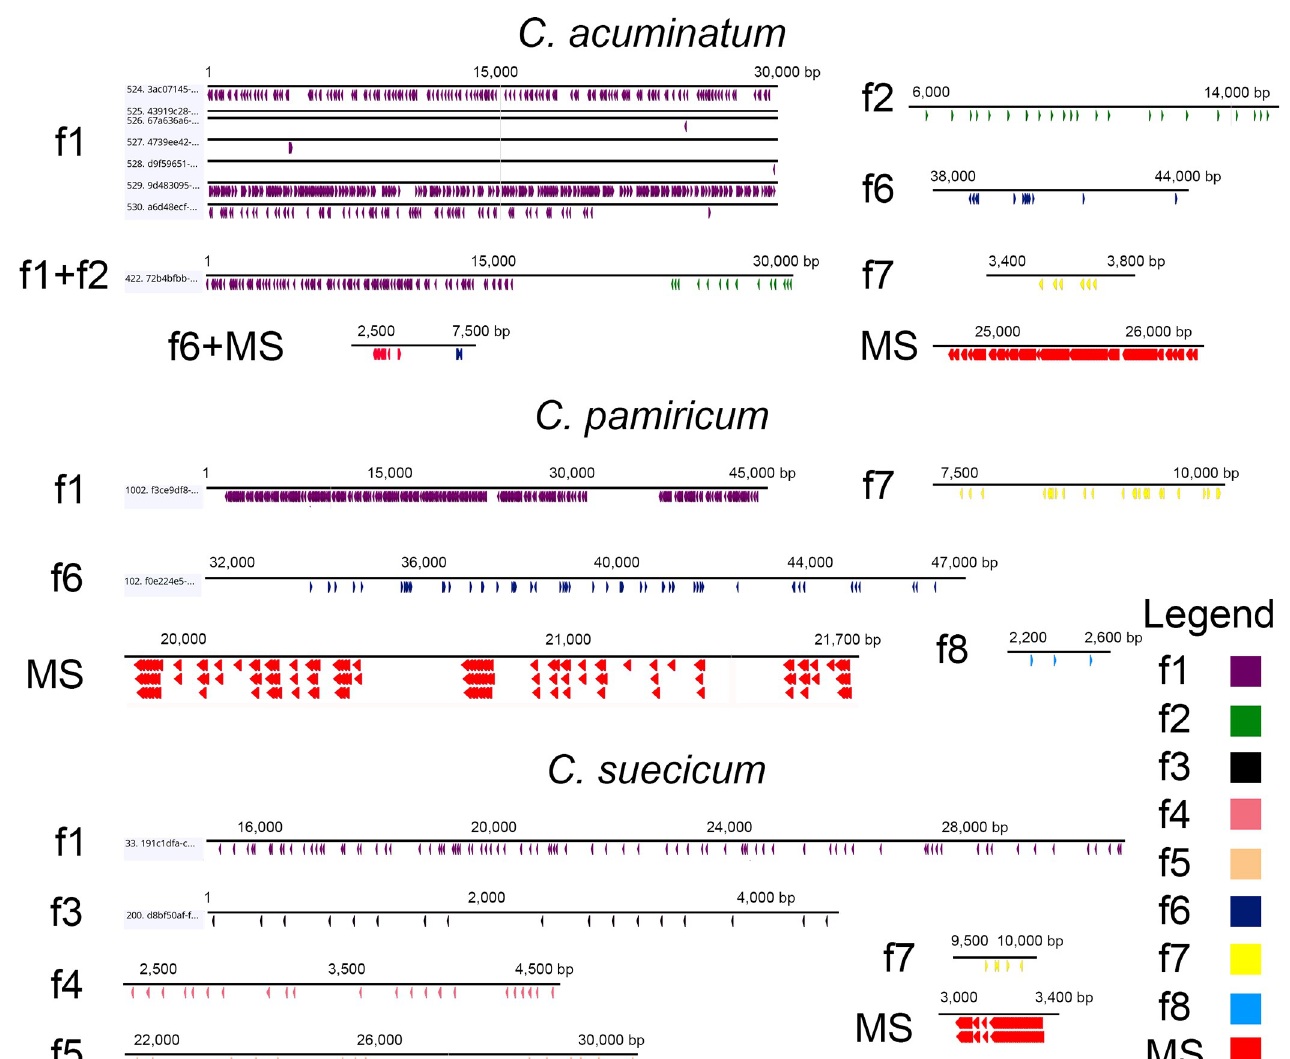
Fig 2. Arrays of satDNA families determined in genomes of three diploid Chenopodium species from ON reads. Screening was conducted on the basis of conserved motifs of satDNA family monomers (Table 2, S1 Table). satDNA family designation is the same as in the text, MS–microsatellites.